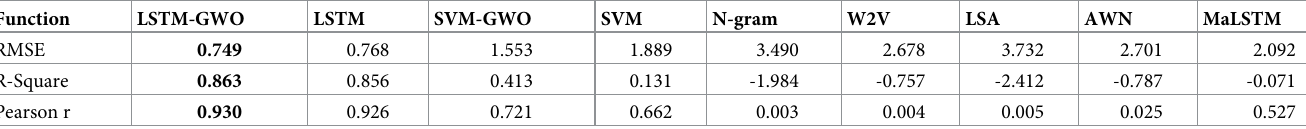
Table 11. Comparison of the proposed model and compared models with experiment 7.